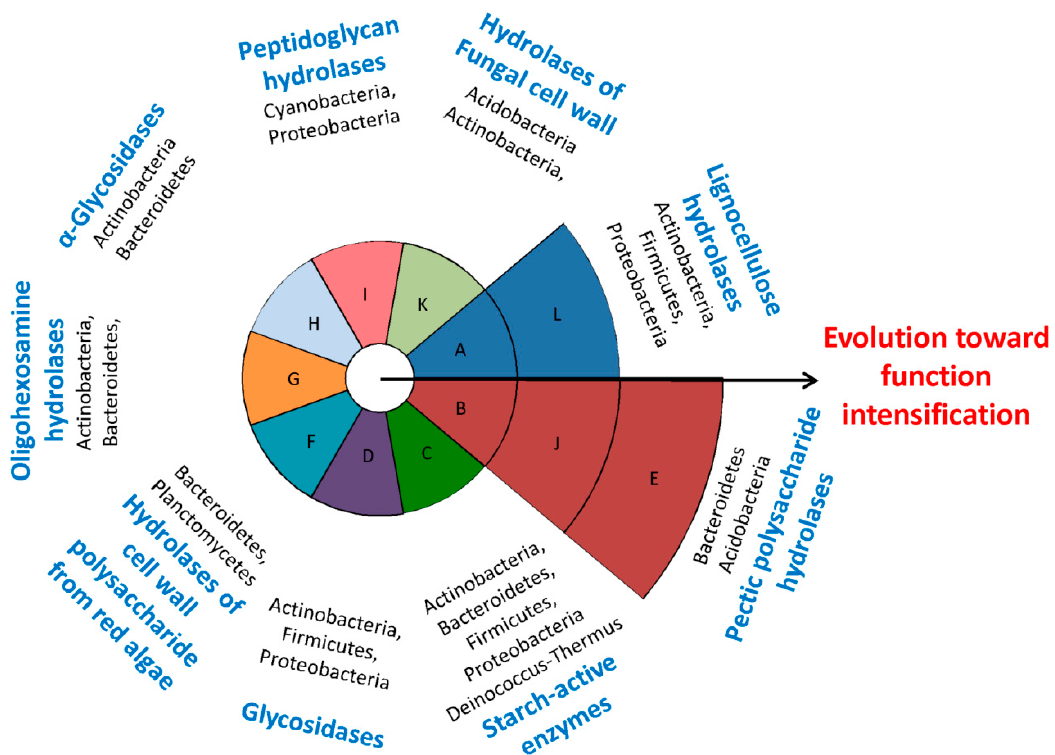
Figure 5. Overview of the functional categories and their corresponding dominant microbial phyla, as well as their relationships of progressive enrichment of specific GHFs.